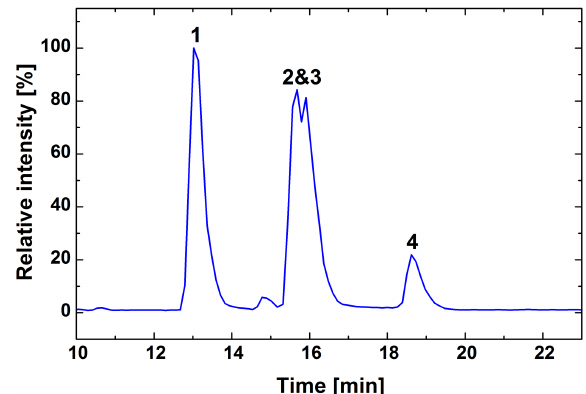
Figure 3. Base peak chromatogram of the synthesised mixture for mass range m/z 100 − 650, showing the separation of pinic acid (1), monoperoxypinic acid isomers I and II (2, 3), and diperoxypinic acid